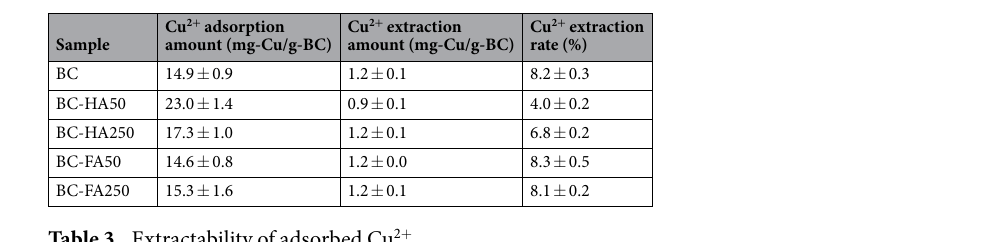
Table 3. Extractability of adsorbed Cu 2 +